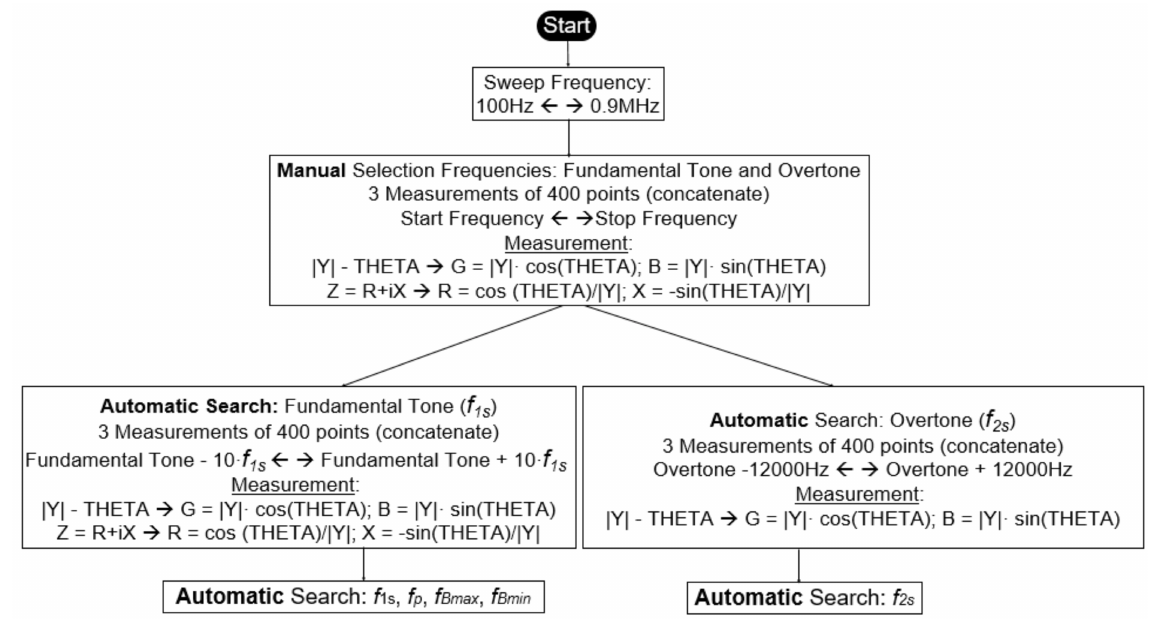
Figure 5. Procedure for searching for the frequencies f 1s , f p , f Bmax , and f Bmin from the fundamental tone and f 2s from the first